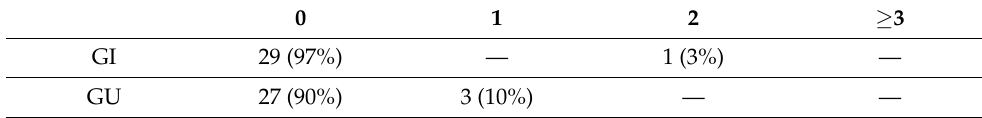
Table 3. Maximum acute toxicity during radiation or within 3 months after